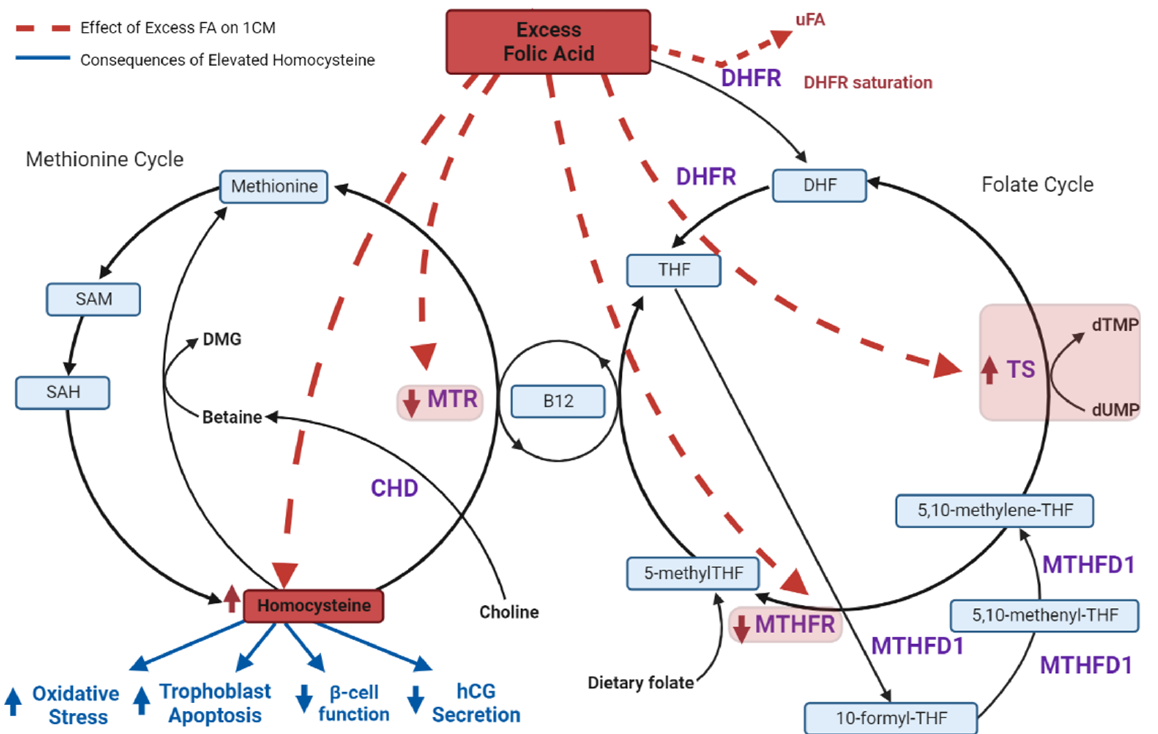
Figure 3. Overview of the effects of supraphysiological FA on one-carbon metabolism. Excess FA has demonstrated reduced methylenetetrahydrofolate reductase (MTHFR) activity in humans and mice favouring the thymidylate synthase (TS) cycle at the expense of methionine synthase (MTR) activity in C. elegans and elevated homocysteine in C. elegans , human choriocarcinoma BeWo and JEG3 cells.